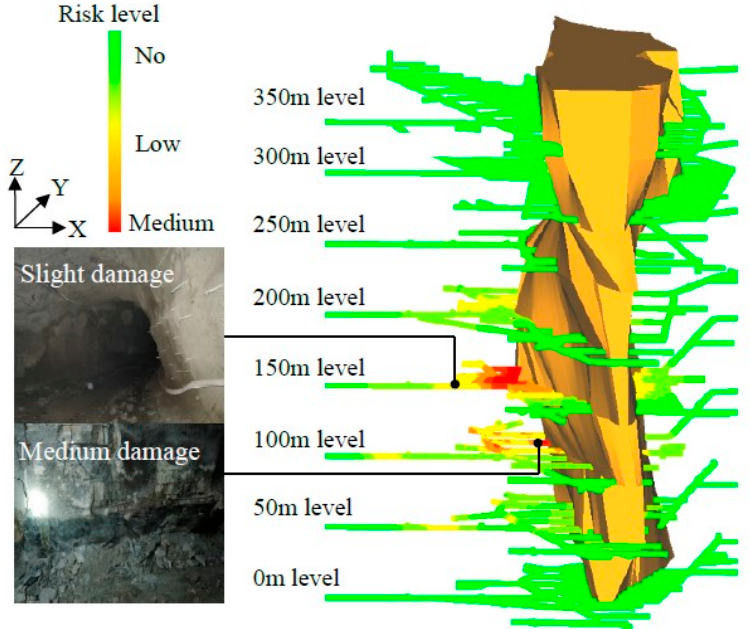
Figure 13. Risk assessment matrix of tunnel damage.